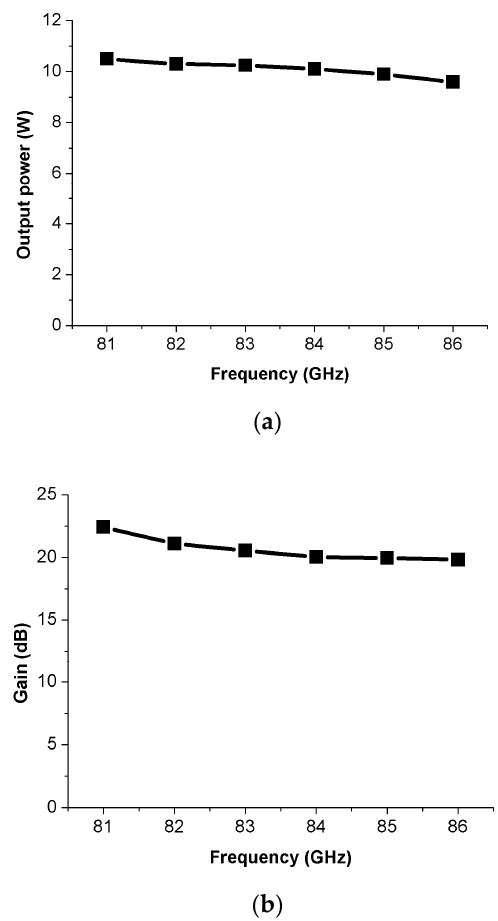
Figure 17. The output power ( a ) and gain ( b ) of CV-FWG simulated by PIC.